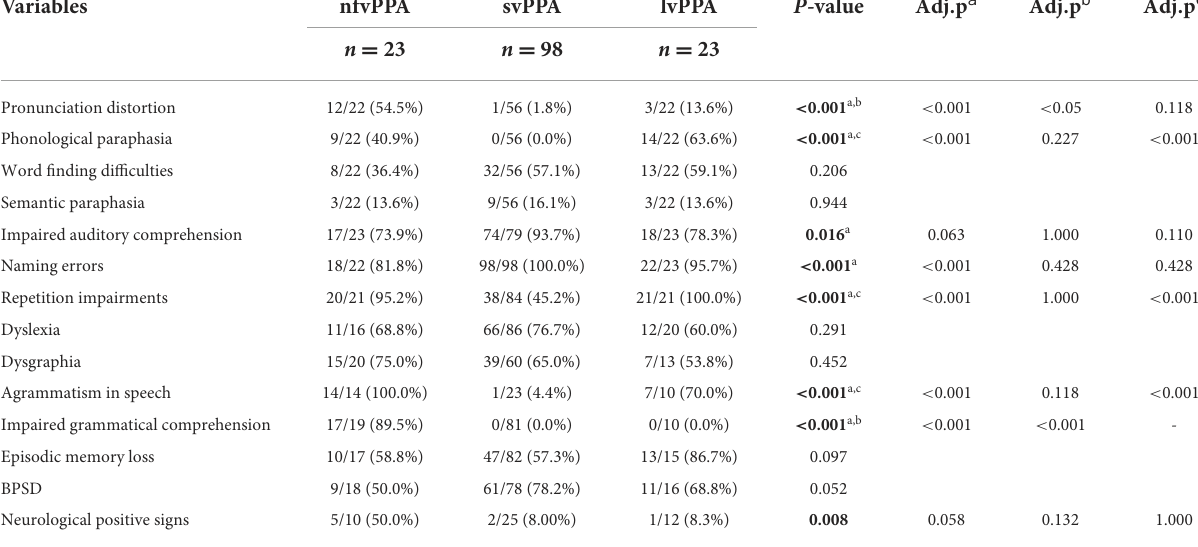
TABLE 2 Clinical manifestations of patients with PPA variants.